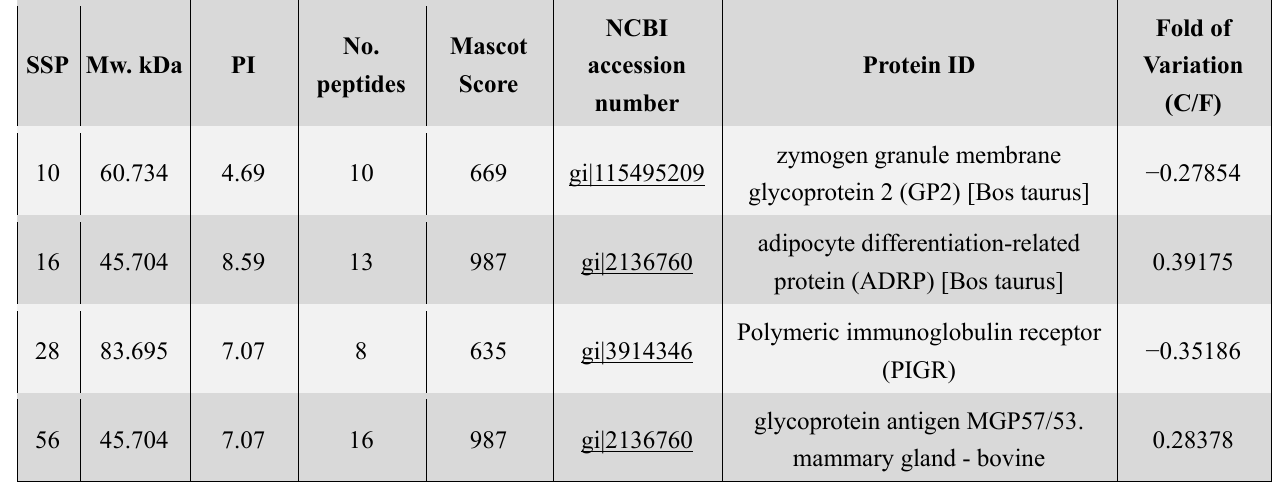
Table 1. Differences in MFGM fractions, Chianina vs . Holstein breed. Spot number (SSP), protein molecular weight (Mw, kDa ) , isoelectric point (PI), number of peptides successfully identified by mass spectrometry (No. peptides), mascot score, protein accession numbers, protein ID and variation